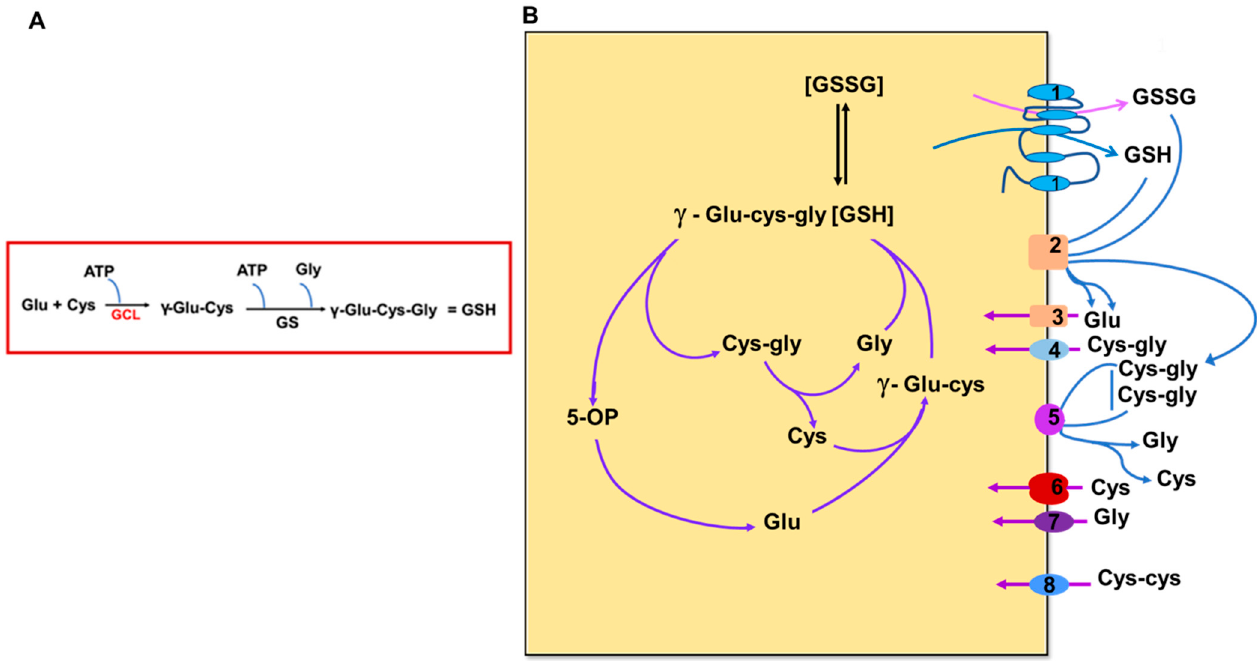
Figure 2. Scheme showing the biosynthesis of GSH ( A ), and the glutathione cycle and transport of constituent amino acids and related substrates ( B ). Figure 2B is modified from Bachhawat AK, Yadav S. The glutathione cycle: glutathione metabolism beyond the γ -glutamyl cycle. IUBMB Life. 2018 July; 70(7):585–592. doi: 10.1002/iub.1756. Epub 2018 Apr 17. PMID: 29667297. Wiley Publishers [19]. GCL—glutamate–cysteine ligase, GS—glutathione synthetase, GSH—glutathione. 5-OP-5-oxoproline. Numbers refer to representative transporters involved. 1–2. MRP family; 3. EAATS family; 4. Peptide transporters; 5–6. System Xc − and other transporters; 7. Glycine transporter; 8. Disulfide transporter.